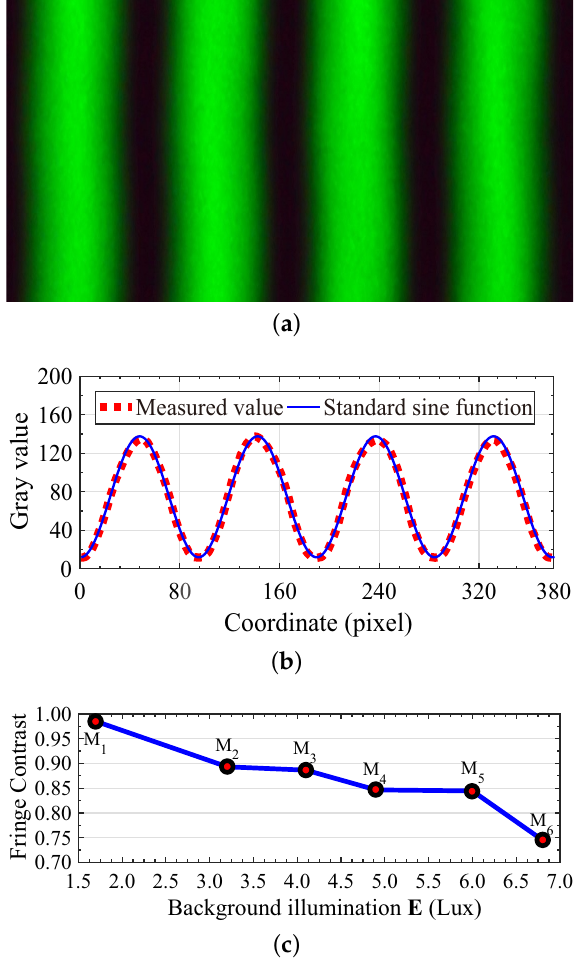
Figure 3. The generated sinusoidal fringe pattern. ( a ) the measured intensity distribution; ( b ) comparison intensity-distribution curve with standard sine curve; ( c ) the measured fringe contrast corresponding to different background illumination for a given-power